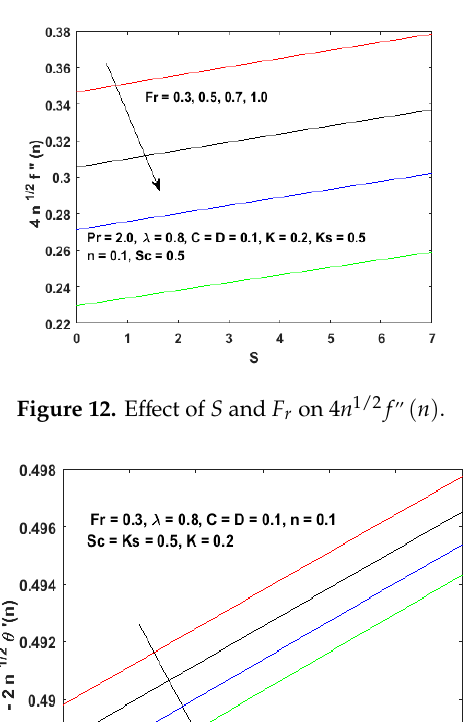
Figure 11. Effect of the Schmidt number ( Sc ) on